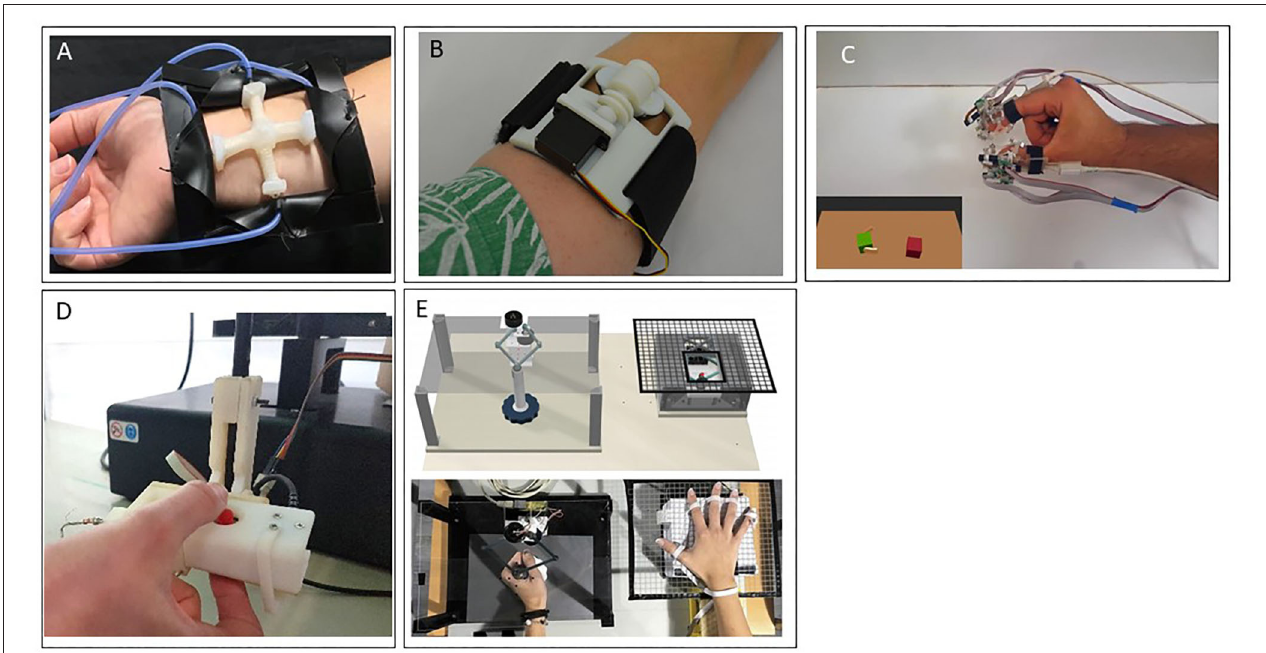
FIGURE 2 | Skin deformation—tangential and stretch stimulation devices. (A) A wearable device that is comprised of pneumatic actuators to guide motion direction ( Kanjanapas et al., 2019). (B) The Rice Haptic Rocker that was designed to convey proprioceptive information to users of prostheses (Battaglia et al., 2019). (C) A wearable device that was used to render virtual environment forces (Schorr and Okamura, 2017b). (D) An aperture and tactor skin-stretch device that was used to study the contribution of tactile stimulation of the fingertips to motor adaptation ( Avraham and Nisky, 2020). (E) The Tactile-STAR, a skin brushing stimulator (top right) and a recorder (top left) that were used to assess and train tactile perception acuity. The device was specifically designed to be appropriate for use with stroke survivors who may have difficulty in maintaining contact with an aperture and tactor type of a device ( Ballardini et al.,